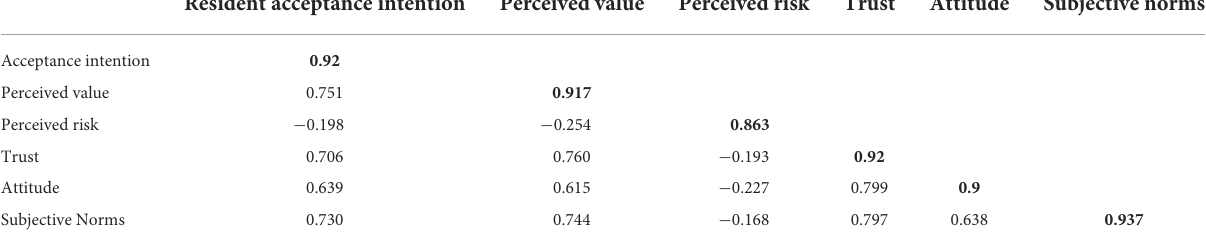
TABLE 4 Discriminant validity of measurement models.